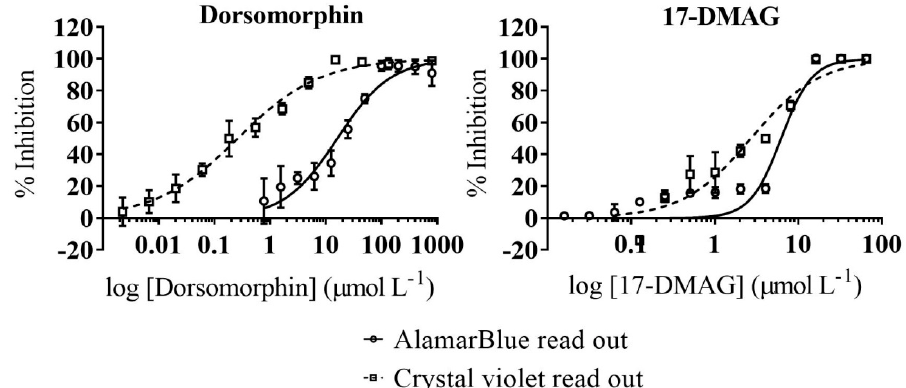
Figure 3. Dose–Response Curves of Vero Cell Toxicity Assays. AlamarBlue readout is represented by empty circles and straight line while crystal violet read out by empty squares and dashed line. Graphs represent mean results and SD of at least three biological replicas.